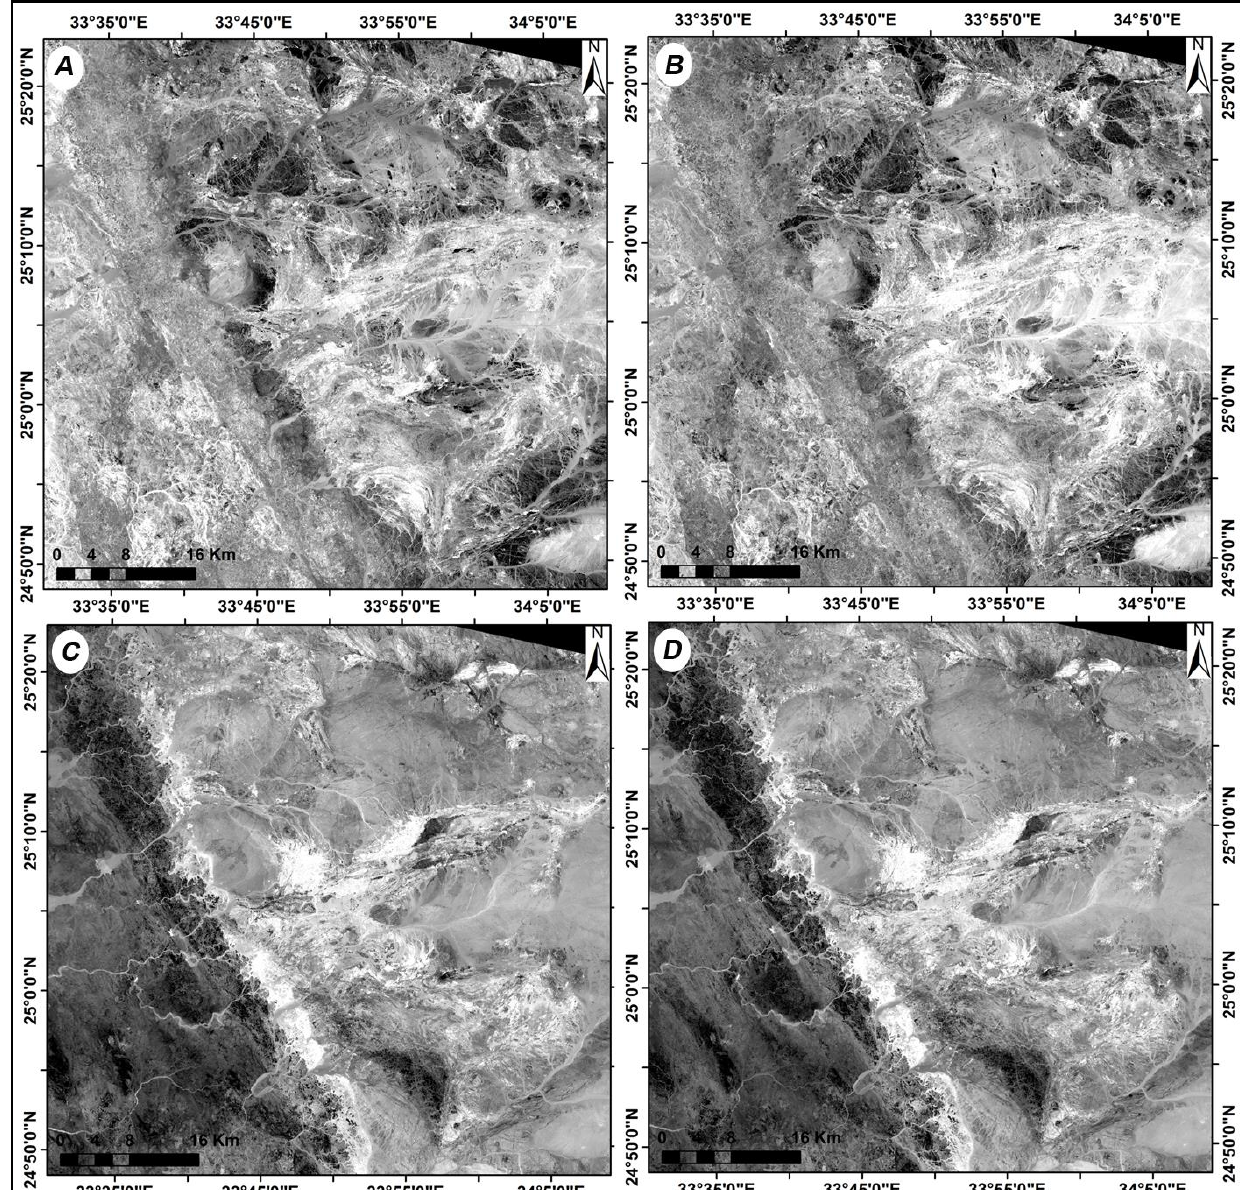
Figure 12. Greyscale band ratio images of ( A ) Landsat-8 bands (6/7), ( B ) predicted hyperspectral bands (142/201), ( C ) Landsat-8 bands (5/6), and ( D ) predicted hyperspectral bands (53/142).